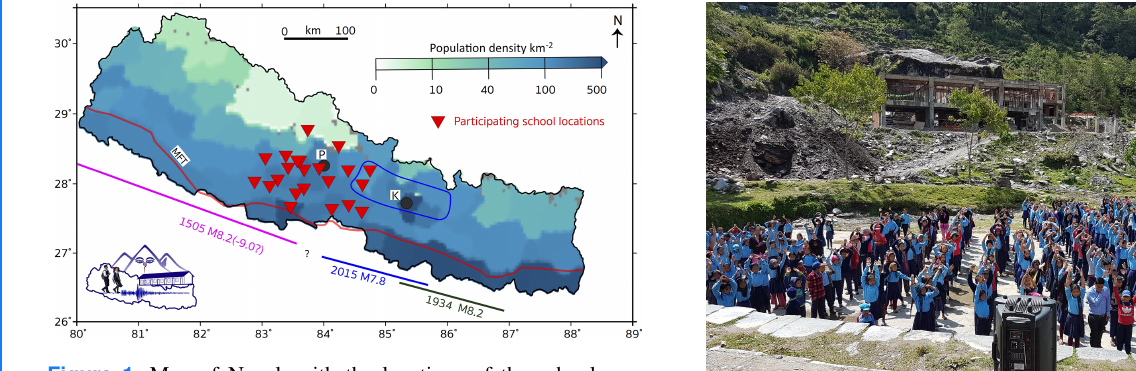
Figure 1. Map of Nepal, with the locations of the schools par- ticipating in the Seismology at School in Nepal program. The background represents population density data (CIESIN and CIAT, 2005). The Main Frontal Thrust (MFT), the surface trace of the fault underlying most of Nepal and hosting all great earthquakes in the region, is indicated with a red solid line. Three colored seg- ments represent the rupture extent of the corresponding major and great earthquakes with moment magnitude ( M w ), as indicated (after Bollinger et al., 2016). For the 2015 Gorkha earthquake, the rupture area is also plotted (blue contour). The letters P and K refer to cities of Pokhara and Kathmandu, respectively, marked with black circles.